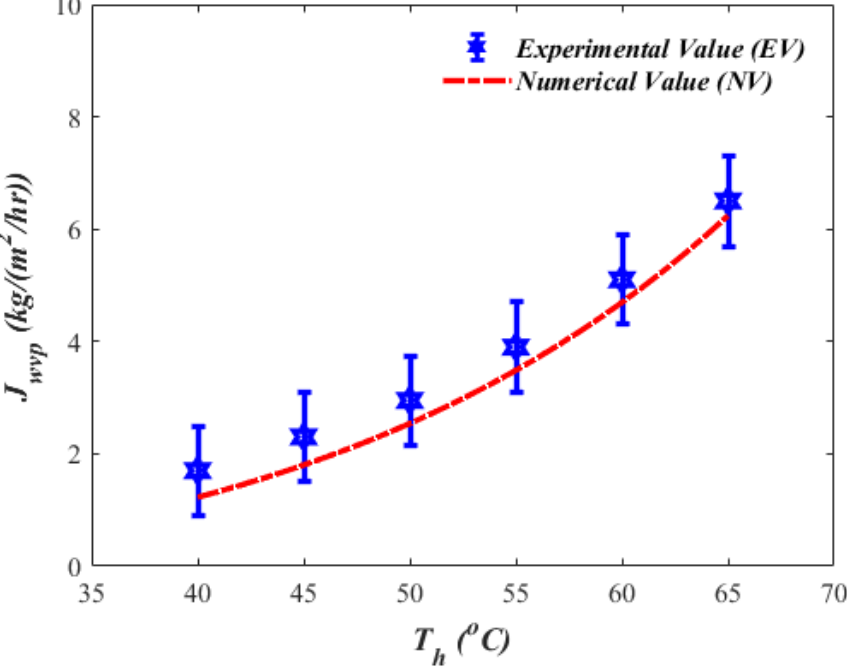
Figure 18. Permeate flux (J wvp ) comparison, experimental vs. numerical.